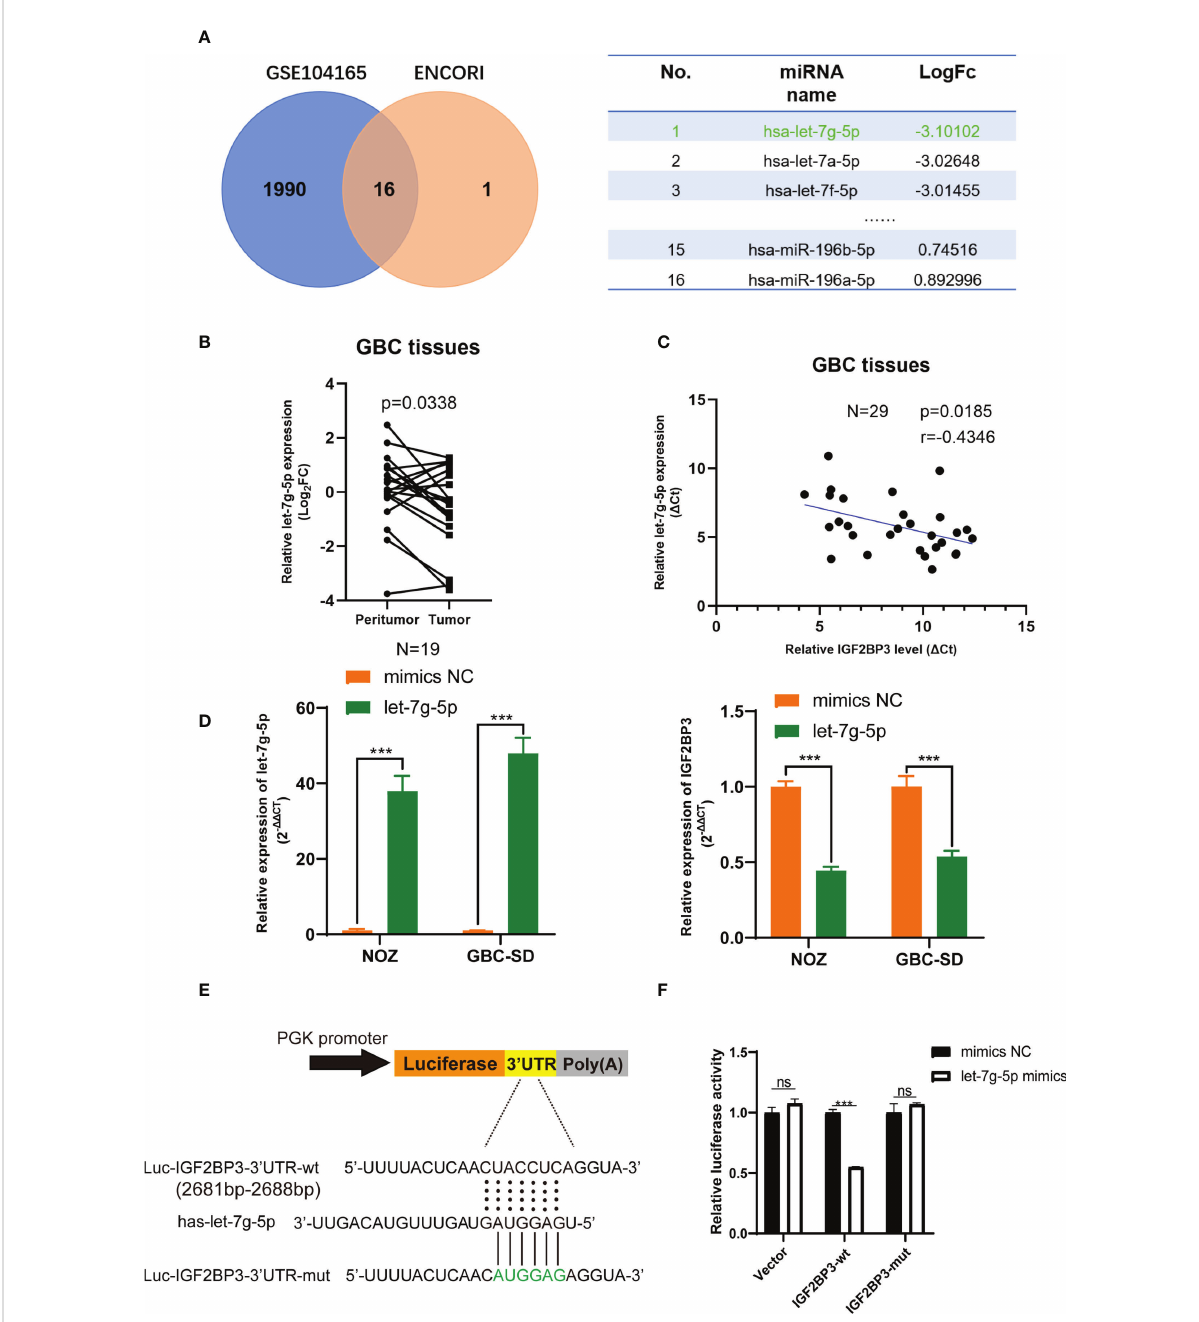
FIGURE 6 let-7g-5p represses IGF2BP3 by directly targeting its 3 ’ UTR. (A) Venn diagram of GSE104165 and the predicted miRNA from ENCORI. The predicted result is listed in the table on the right. (B) The expression level of let-7g-5p in 19 pairs of GBC tumor and peritumoral tissues was detected by qPCR. (C) Pearson correlation test was conducted to investigate the relationship between let-7g-5p and IGF2BP3. (D) The NC and let-7g-5p mimics were respectively transfected into GBC cells to overexpress let-7g-5p. The expression level of let-7g-5p (left) and IGF2BP3 (right) was veri fi ed via qPCR. (E) Luciferase reporter plasmids containing IGF2BP3-3 ’ UTR and the point-mutant plasmids were constructed. (F) The result of dual-luciferase reporter assay showed let-7g-5p could silence IGF2BP3 via directly interacting with the 3 ’ UTR of IGF2BP3. Paired t test was used in (B) Unpaired t test was used in (D, F) Data is shown as mean ± SD; *** P < 0.001. ns means no signi fi cance in statistical